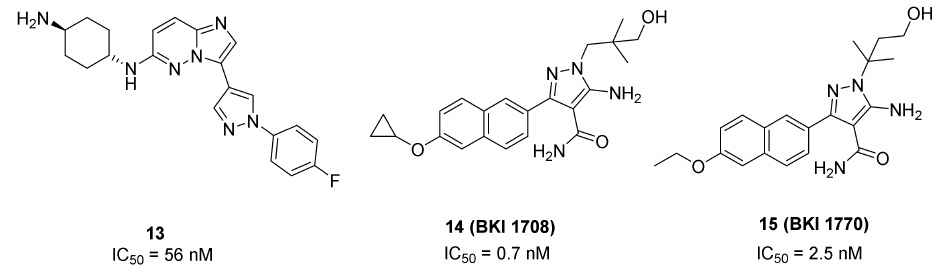
Figure 24. Structures of pyrazole-based calcium dependent kinase inhibitors and their IC 50